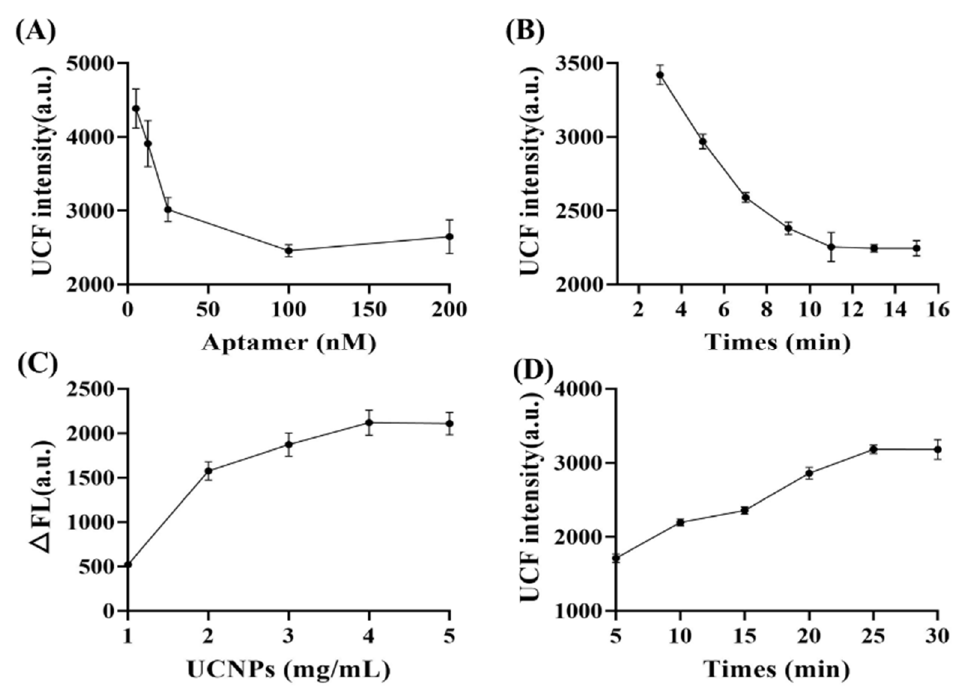
Figure 6. Optimized condition of apt1 ( A ), the incubation time of apt1 − GNPs ( B ), apt2 − UCNPs ( C ), and the incubation time between the probe and Shigella ( D ).